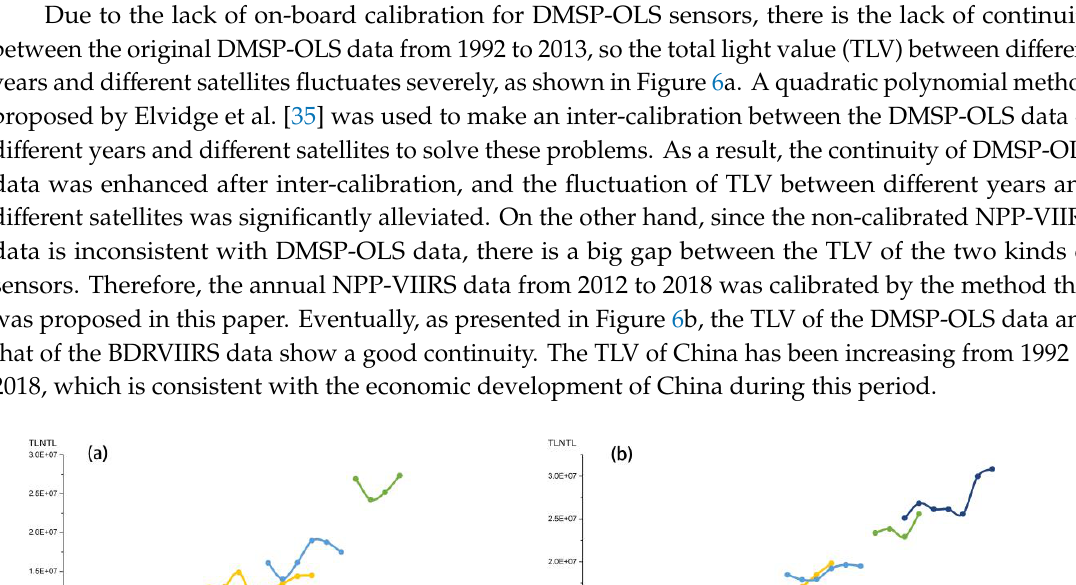
Figure 5. Scatter density plot of DMSP-OLS and unsmoothed BDRVIIRS in the whole China region ( a ), which corresponds to Point a in Figure 4. Scatter density plot of DMSP-OLS and smoothed BDRVIIRS undergoing a Gaussian low pass filter (σ = 1.51, w=15) ( b ), which corresponds to Point b in Figure 4.